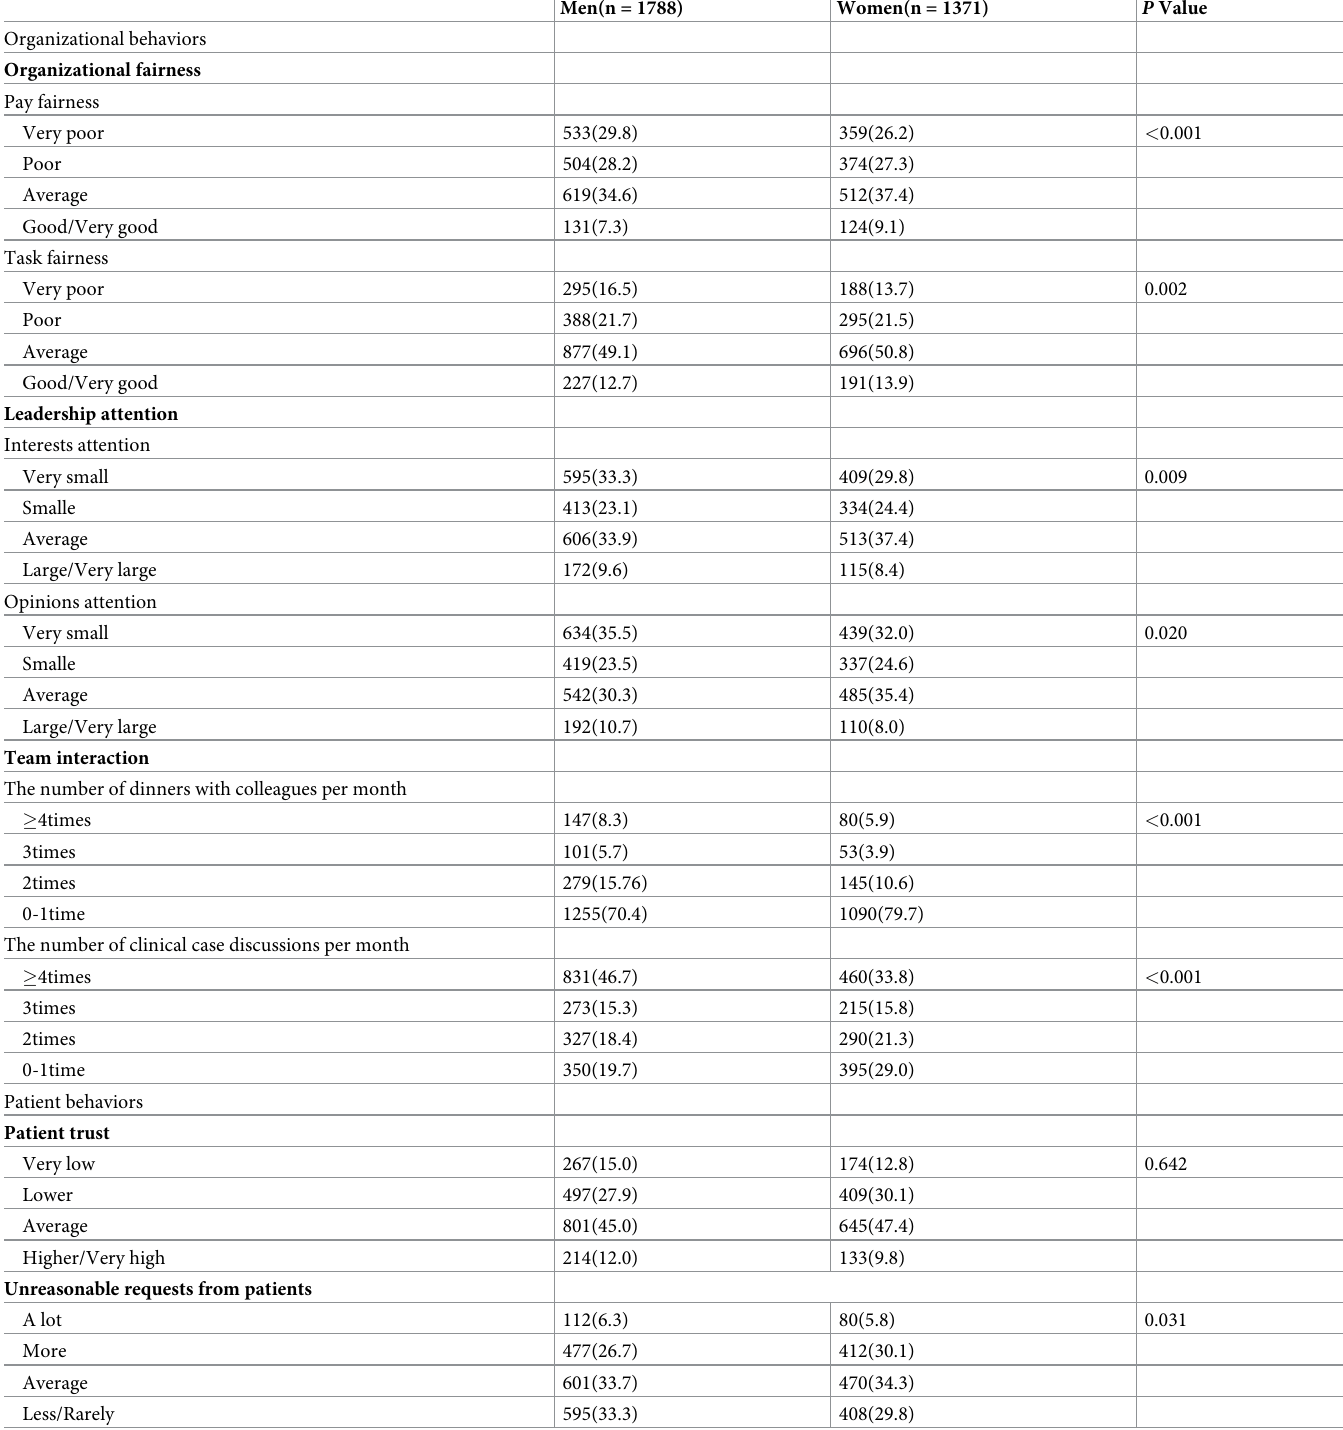
Table 2. The characteristics of physicians’ self-perceived organizational and patient